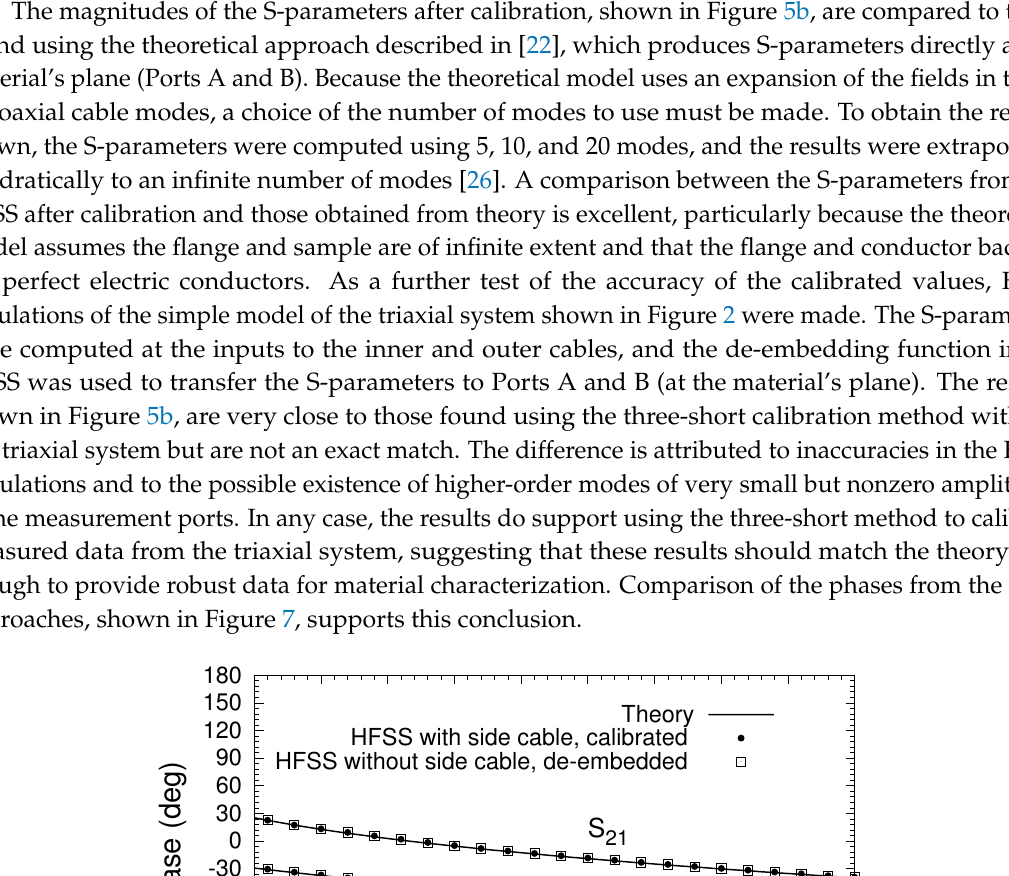
Figure 6. Magnitudes of the S-parameters of transition B. Side-cable placement was based on the behavior of across the operating band. S 21 | |